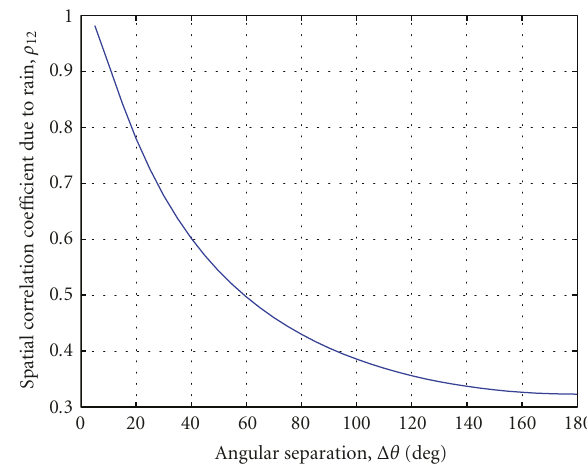
Figure 2: Normalized radiation pattern of each TS antenna com- patible with ITU-R specifications [25].